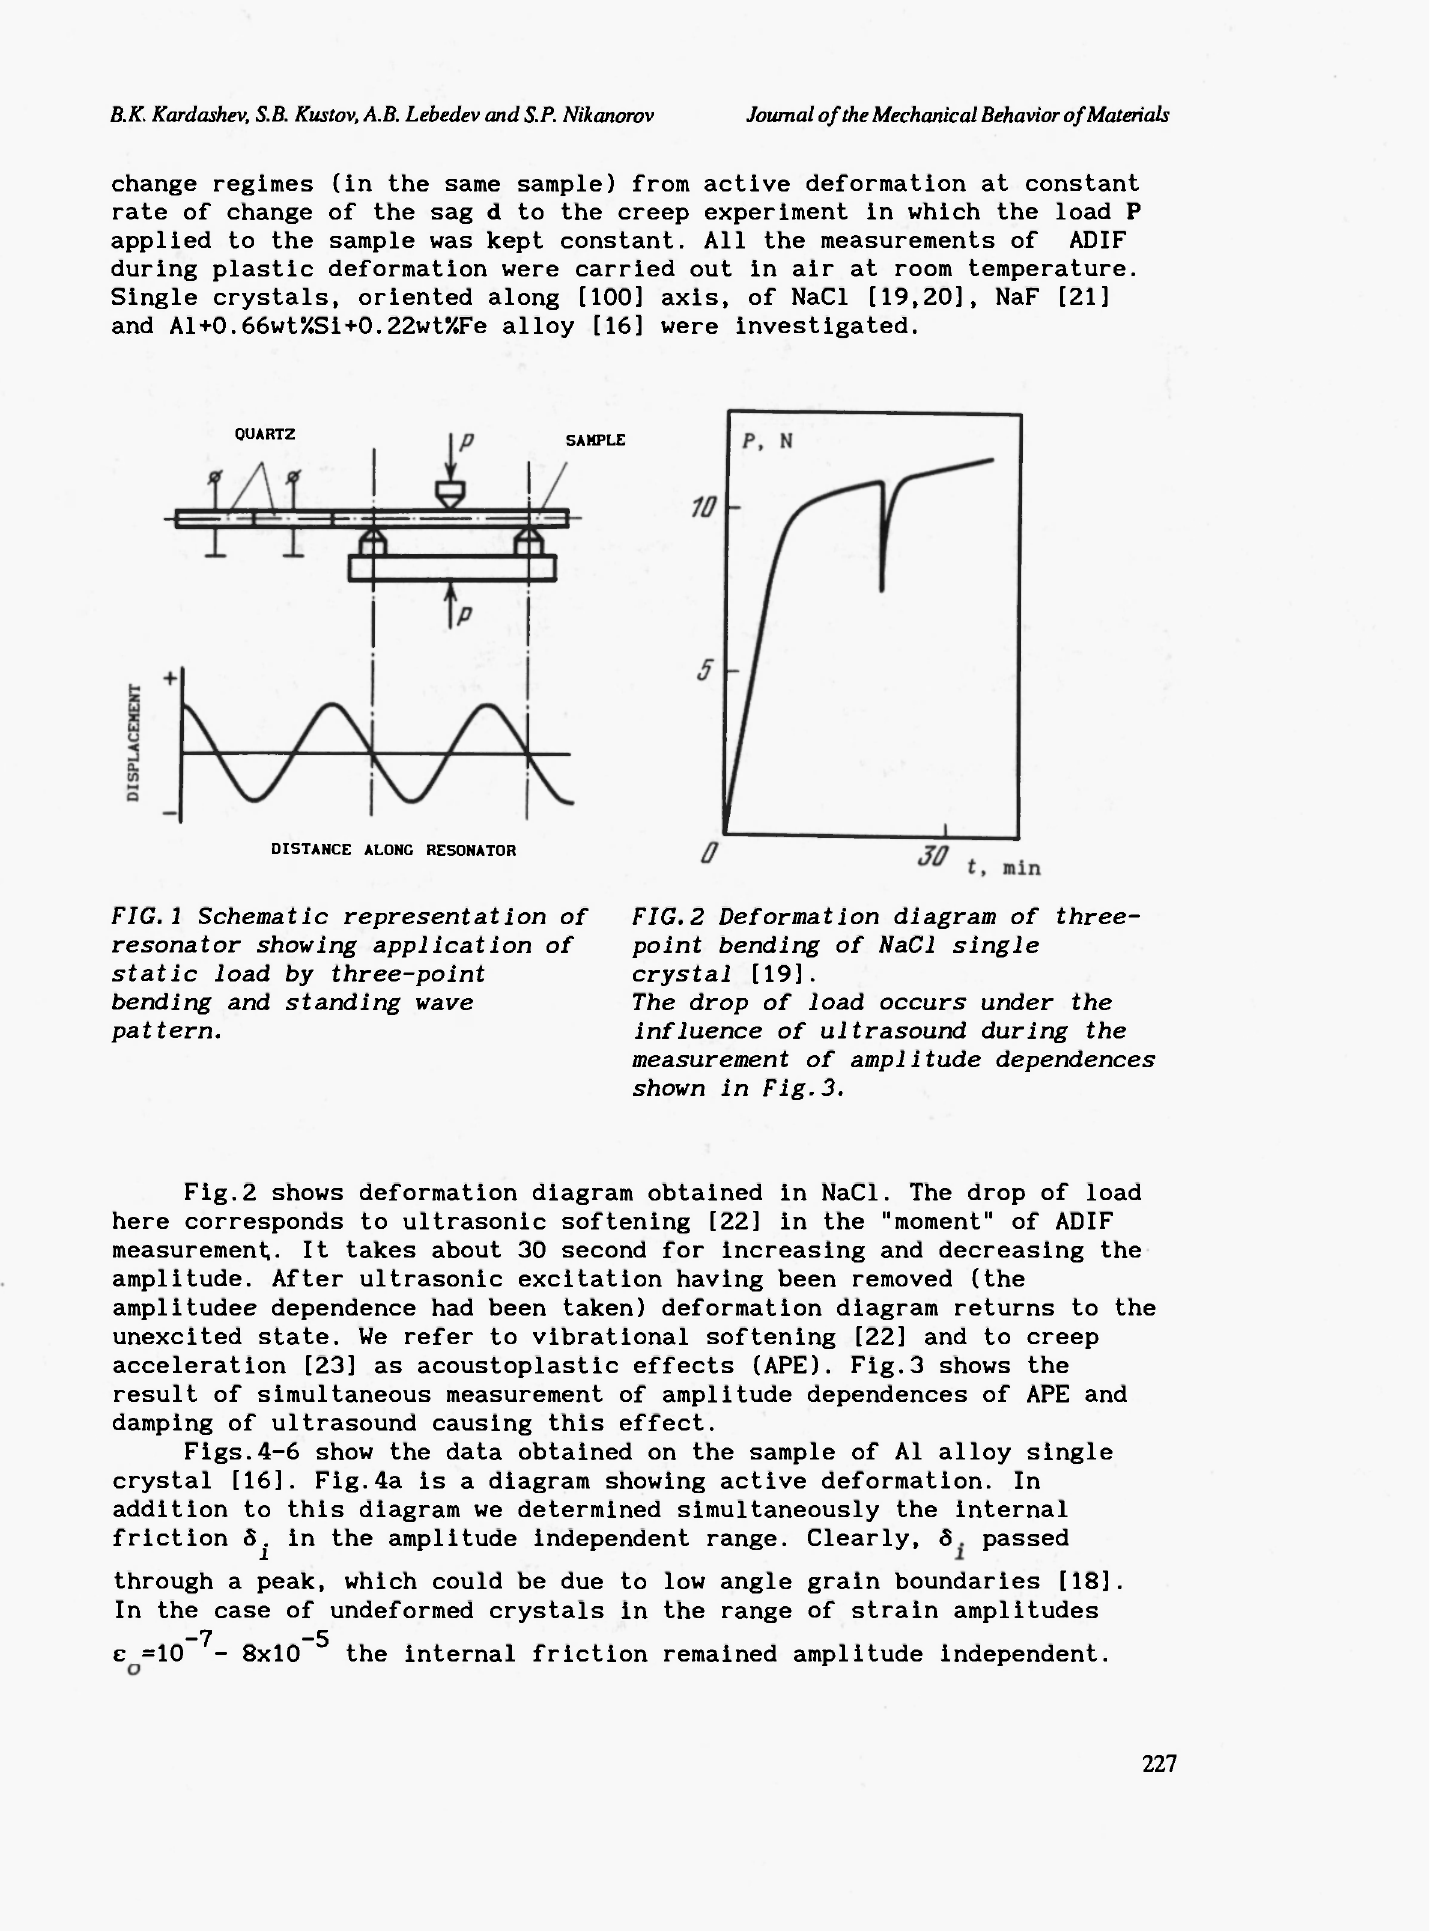
FIG.2 Deformation diagram of three- point bending of NaCl single crystal [19]. The drop of load occurs under the influence of ultrasound during the measurement of amplitude dependences shown in